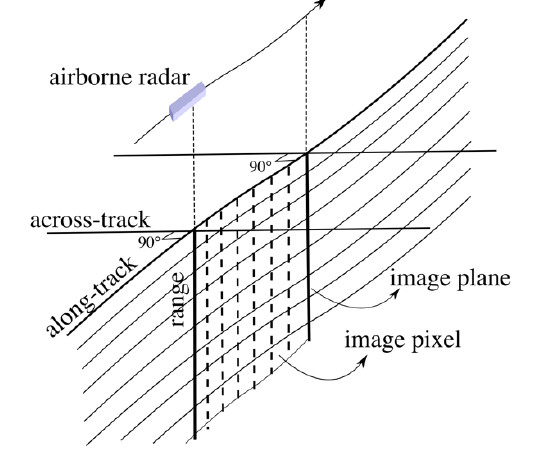
Figure 1. Imaging geometry of Ice Penetrating Radar